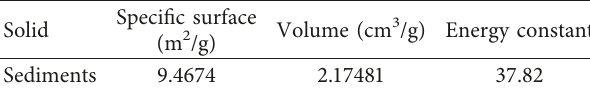
Figure 3: Adsorption-desorption isotherms of N Table 1: Textural characteristics of